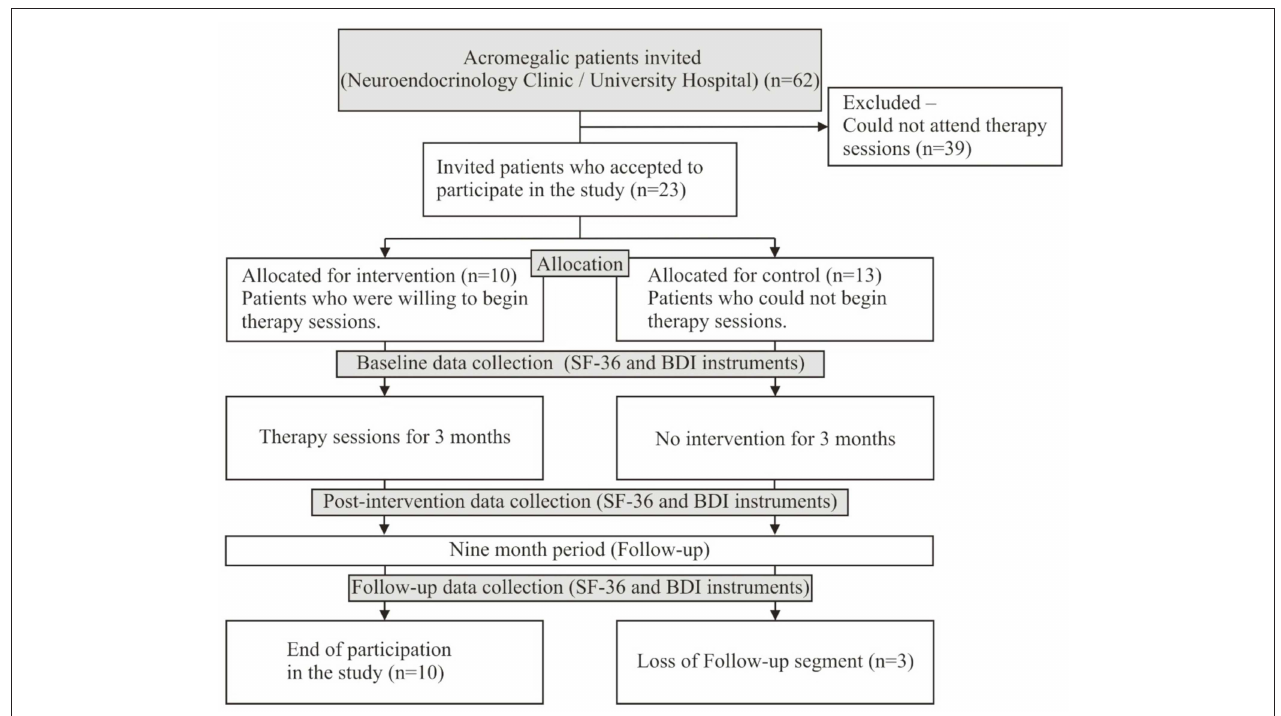
FIGURE 1 | Sample composition and evaluation